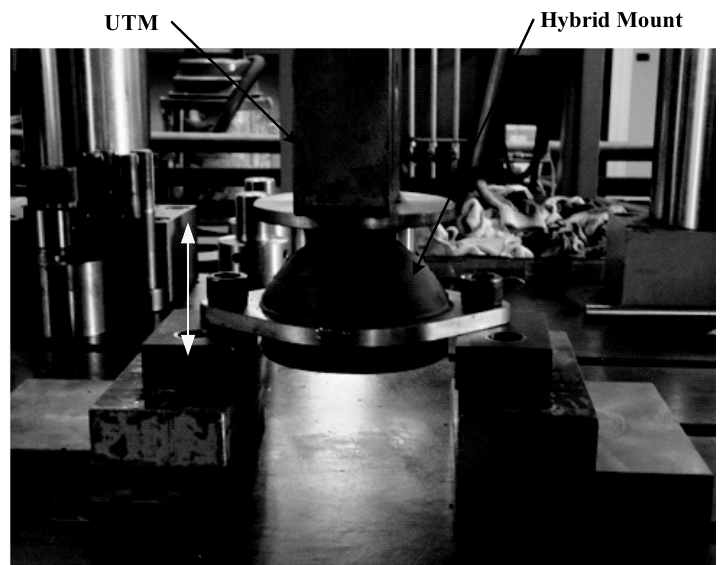
Fig. 12. Photograph of strength test in the axial